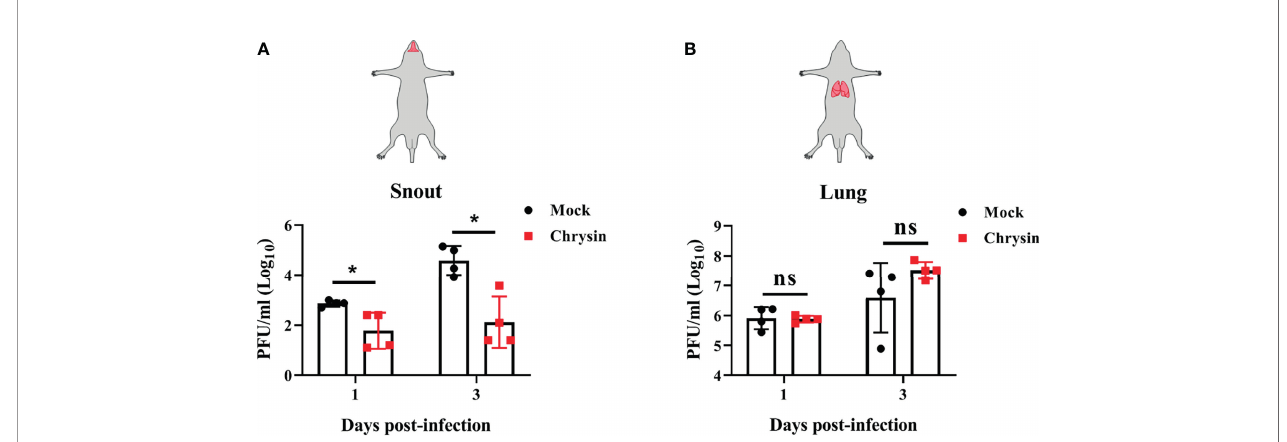
FIGURE 8 | Intragastrical administration of chrysin blocks H1N1 in fl uenza virus replication in the upper airways. C57BL/6 mice were intranasally infected with18 PFU A/PR/8/34 (H1N1) virus in a total volume of 40 m l for 2 hours, then animals were administered chrysin (100 mg/kg) daily by gavage before being sacri fi ced. Snout (A) and lung (B) samples were harvested on days 1 and 3 following infection for viral titer analysis. Data are expressed as the mean ± SEM of three independent experiments with a log value. *P<0.05 by unpaired two-tailed Student ’ s t-test. ns, no signi fi cant